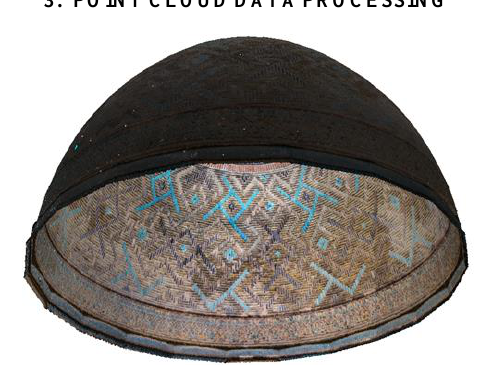
Figure 1. The ideal point cloud of İnce Minareli Madrasa's dome created by raw images.